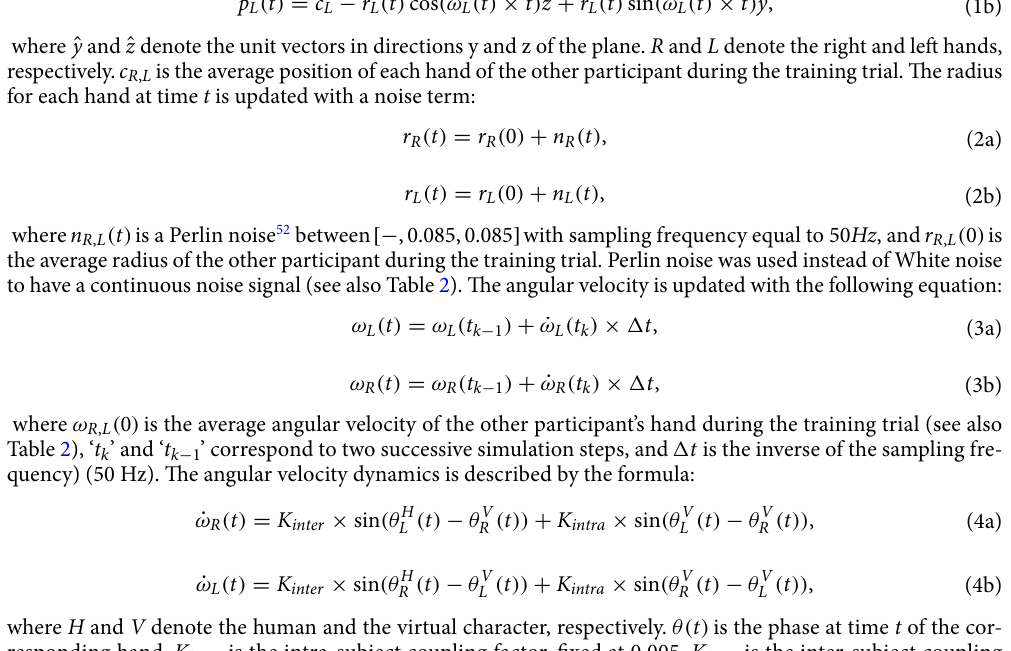
where H and V denote the human and the virtual character, respectively. θ( t ) is the phase at time t of the cor-